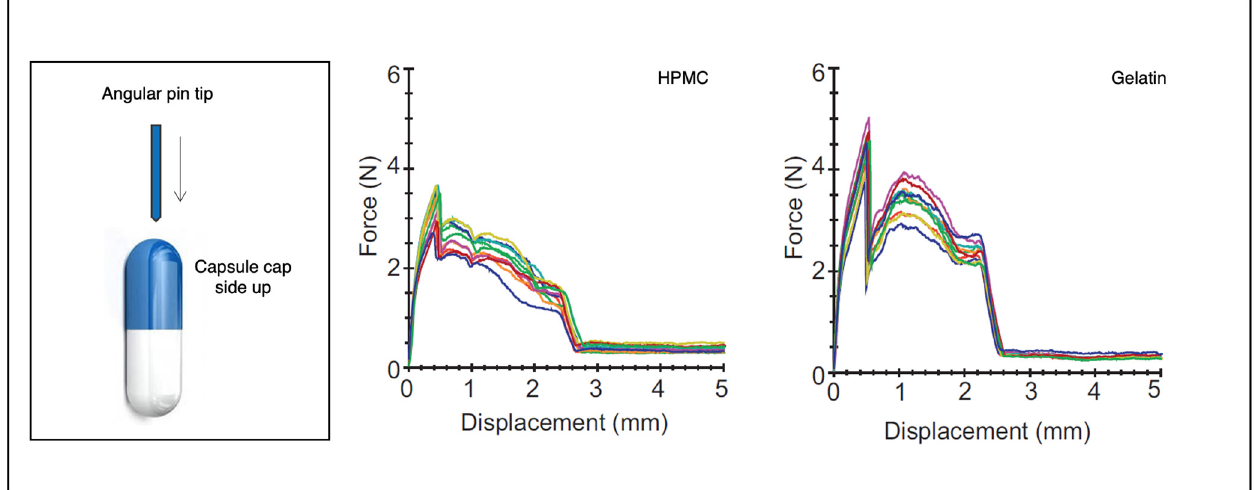
Figure 4. Single-pin puncture curves. Graphs of the displacement of a single angular pin versus the force for both hypromellose and gelatin capsules equilibrated at 33% relative humidity (Adapted from Ref. [36], published by Elsevier, 2013).